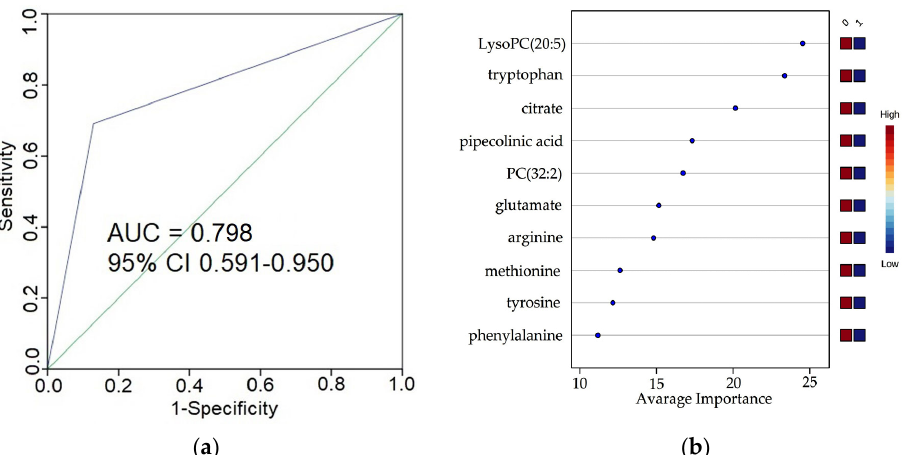
Figure 3. The estimation of the constructed diagnostic model for early stage ccRCC: ( a ). ROC curve and AUC of diagnostic model (generated using 10 metabolites) calculated by using the independent test set. SPSS was used to build the plot; ( b ). Metabolites ranked by their contributions to classification accuracy. The Random Forest algorithm was used. The colored boxes on the right indicate the intensity of the corresponding metabolite m/z peak in the groups (0—control, 1—ccRCC early-stage patients).